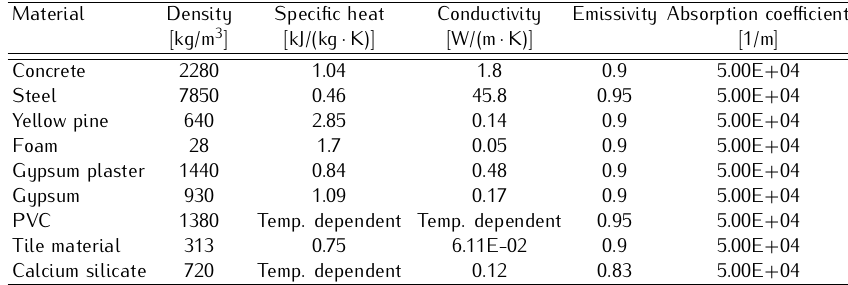
Table 5. Thermal properties of materials.